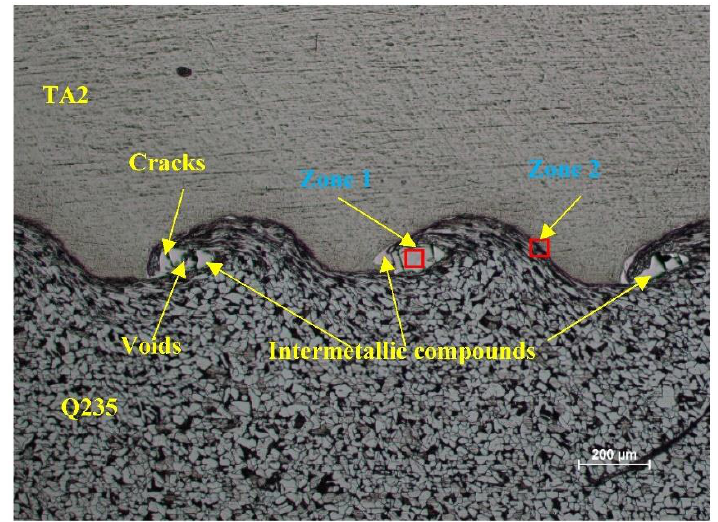
Figure 3. Typical microstructure of the welding interface.